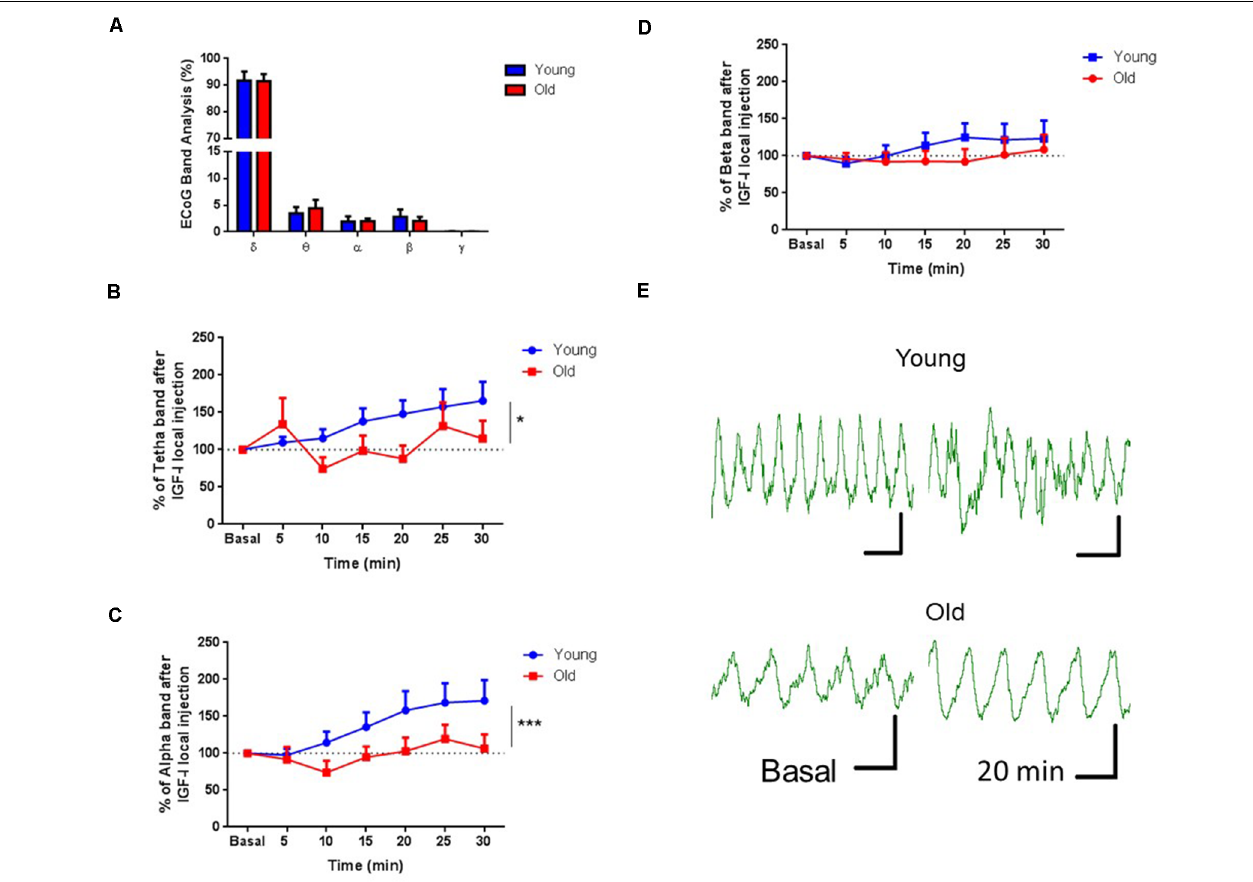
FIGURE 4 | IGF-I injection induced an increase of fast ECoG oscillations. (A) Plot of the percentage of the frequency bands calculated from the power spectrum. No differences were observed in the ECoG band analysis of young and old mice previous to IGF-I application ( n = 9 in each group; F (4,32) = 0.04674; p = 0.9957, Two-way RM ANOVA). (B–D) Time course of each frequency band’s percentage after local injection of IGF-I in the HDB area (10 µ M, 0.2 µ L). IGF-I induced an increase in the percentage of θ and α oscillations in young but not old mice through 30 min of recording (young = 13, old = 9; F (1,138) = 6,436; * p = 0.0123 and F (1,138) = 11,85; *** p = 0.0008, respectively; Ordinary Two-way ANOVA. The beta band did not show any difference between groups (young = 13, old = 9; F (1,145) = 1.833; p = 0.1779; Ordinary Two-way ANOVA). (E) Representative EEG recording at basal and 20 min after IGF-I in both young and old mice. The horizontal bar represents 1 s and the vertical bar represents 20 µ